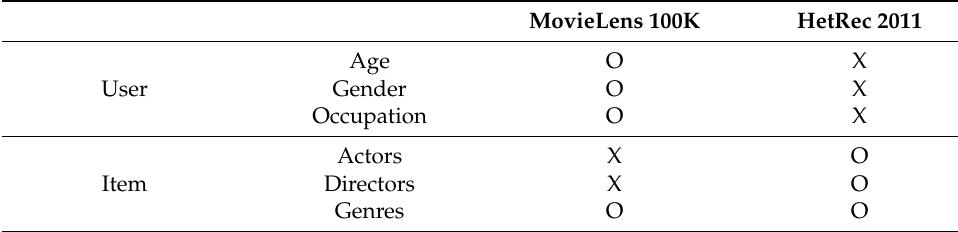
Table 1. Metadata in datasets.